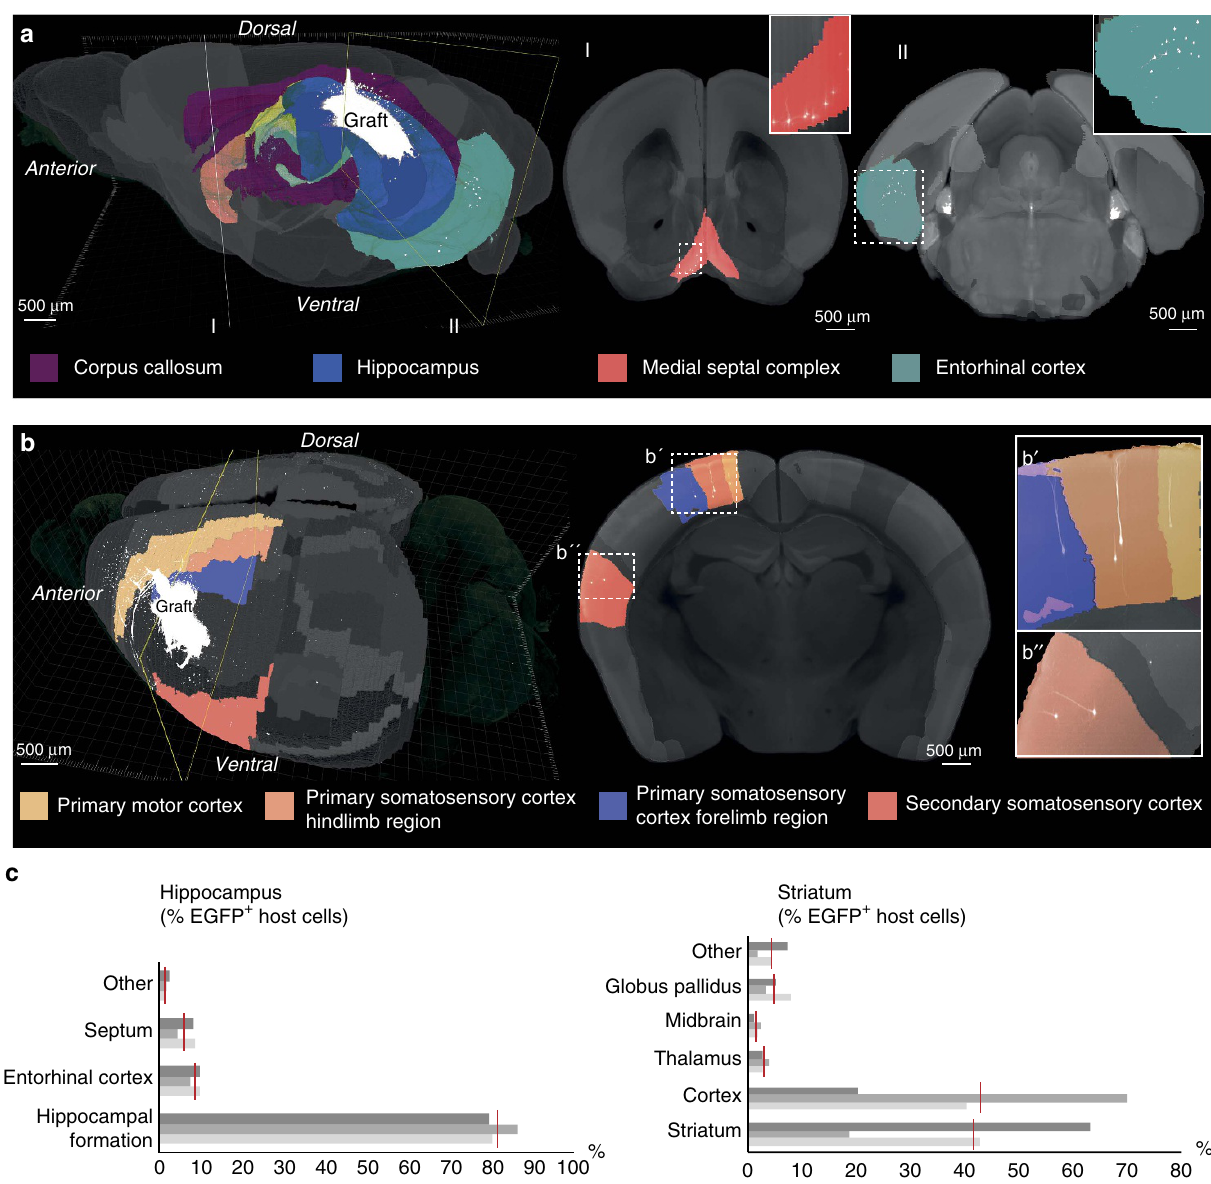
Figure 3 | Anatomical distribution of host neurons projecting onto grafted human neurons. Simultaneous representation of LSFM-recorded EGFP-labelled neurons and co-registration with MRI data in recipient mouse brains with ( a ) hippocampal and ( b ) striatal grafts. Host cells innervating the hippocampal graft are allocated to adjacent hippocampal territories, septum and entorhinal cortex. In brains harbouring striatal grafts, MRI co-registration permitted the allocation of host input neurons to cortical subregions such as motor cortex, secondary somatosensory cortex and distinct areas within primary somatosensory cortex. Shown are representative images from n ¼ 3 cleared brains per transplantation site; scale bars as indicated. ( c ) Quantification and anatomical allocation of EGFP þ host neurons innervating the grafted human neurons. Red vertical bars indicate mean values for 3 recipient animals each (grey horizontal bars). Shown is the percentage of all detected EGFP þ host